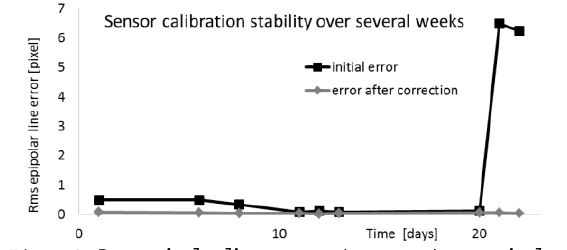
Figure 8: Rms epipolar line error and corrected rms epipolar line error of scanner HS over a period of 22 days